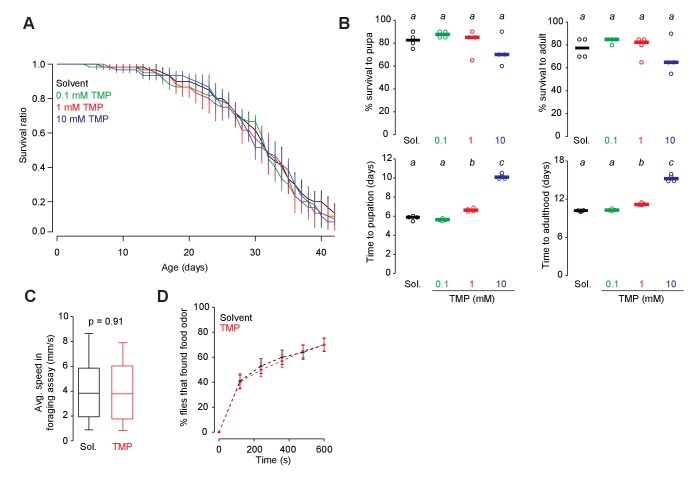
Effect of TMP on survival and behavior.(A) Survival of wild-type flies fed with 0–10 mM TMP from eclosion to death. 15 flies were placed in each vial, four vials per condition. Error bars indicate SEM. (B) Survival (top) and developmental timing (bottom) of flies raised on 0–10 mM TMP. 20 eggs were placed in each vial, four vials per condition, one-way ANOVA with Tukey’s post-hoc test. Significant differences between conditions (p<0.05) are denoted by different letters. Survival to pupa (n = 4, p=0.186, F = 1.88), survival to adult (n = 4, p=0.245, F = 1.58), time to pupation (n = 4, p<0.0001, F = 389.04), and time to adulthood (n = 4, p<0.0001, F = 251.73) (C) Walking speed of wild-type (CS) flies fed with 1 mM TMP or solvent for 48 hr prior to assay (n = 159–161, unpaired t-test, two-tailed). Bar indicates median. Whiskers indicate 90% percentile. (D) Percentage of flies reaching the food odor is plotted against time. Food odor: 1% apple cider vinegar. Error bars indicate SEM.10.7554/eLife.30327.009Figure 1—figure supplement 4—source data 1.Effect of TMP on survival and behavior.